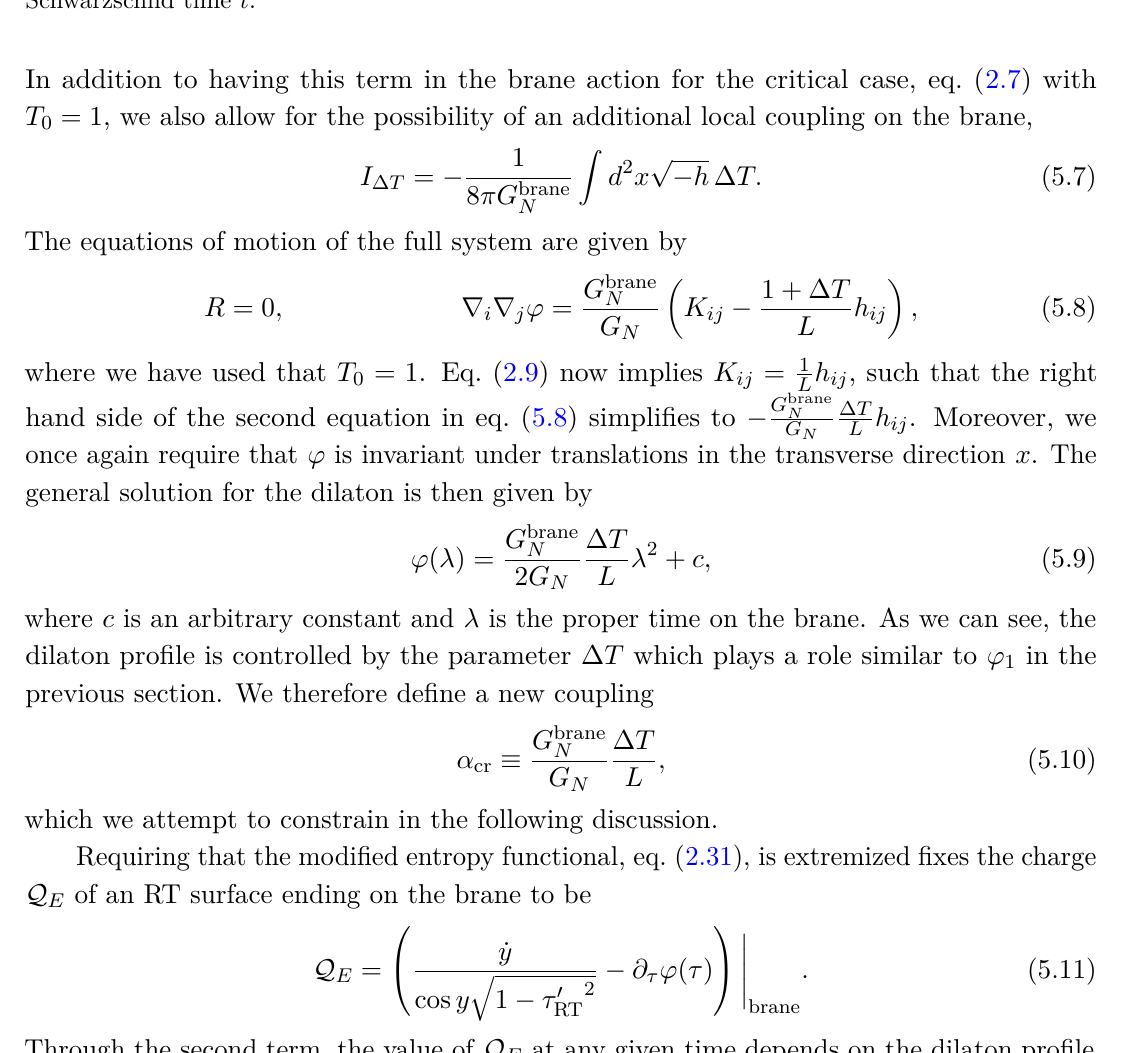
π , which does not correspond to a finite value for the 2 −